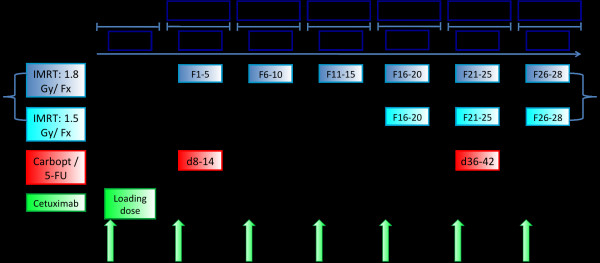
REACH treatment schedule: Cetuximab (Erbitux®) is given at a loading dose of 400 mg/m2 body surface on day 1, the current dose during radiotherapy on days 8, 15, 22, 29, 36 and 43 is 250 mg/m2 body surface. Chemotherapy (Carboplatin 70 mg/m2 body surface/5-FU 600 mg/m2 body surface) is given on days 8-12 and 36-40. Radiotherapy (IMRT) starts one week after the loading dose of cetuximab an day 8. From day 29 onwards, an additional fraction of RT (concomitant boost) will be given to a total dose of 69,9 Gy.